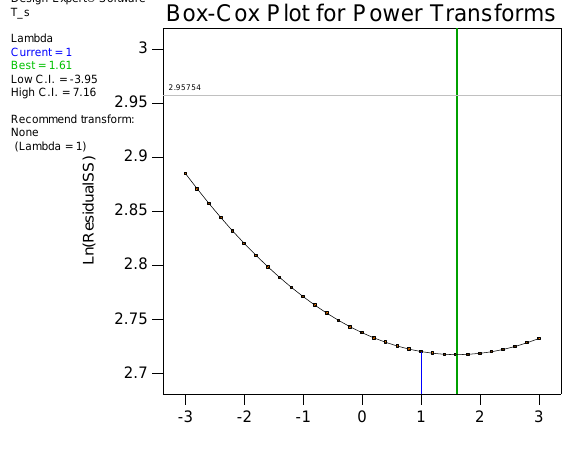
Figure 12: Model diagnostics plots for soil cooling analysis